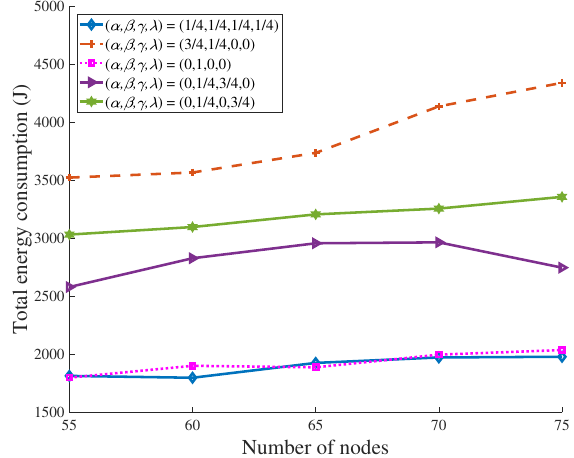
Figure 8. Energy consumption of